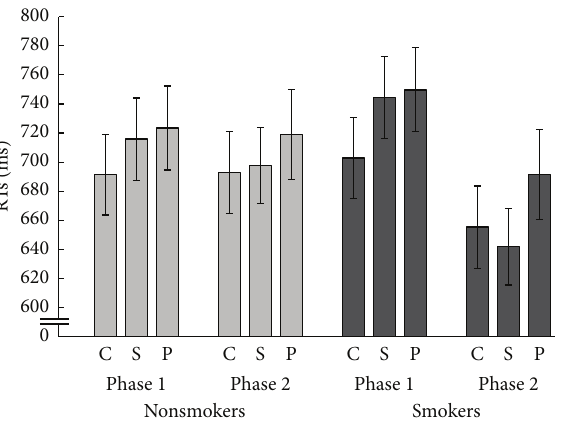
Figure 2: Mean RTs and SEM for each stimulus condition (c, s, and p) for smokers and nonsmokers in phases 1 and 2 of the